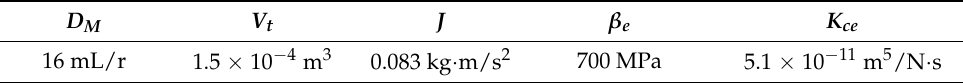
Table 1. Parameters of the hydraulic